Question: What direction does the quantity move in — increasing or decreasing?
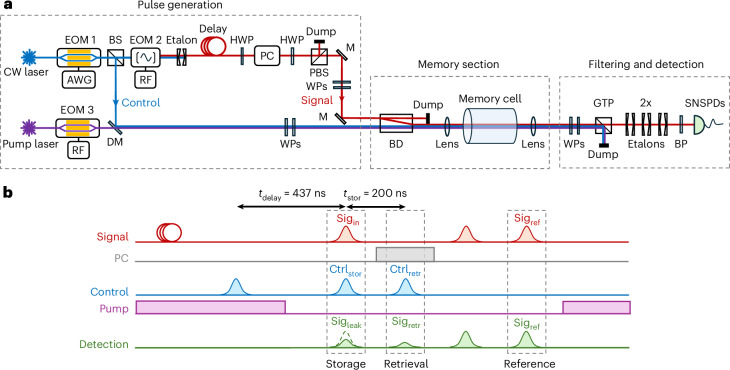
Answer: increasing